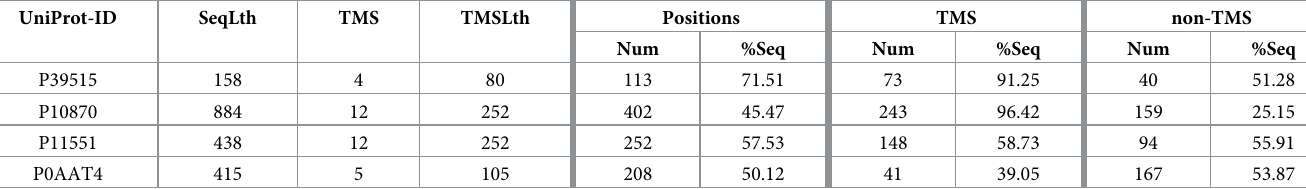
Table 8. Examples of the informative residues distribution with respect to TMS and non-TMS. UniProt-ID